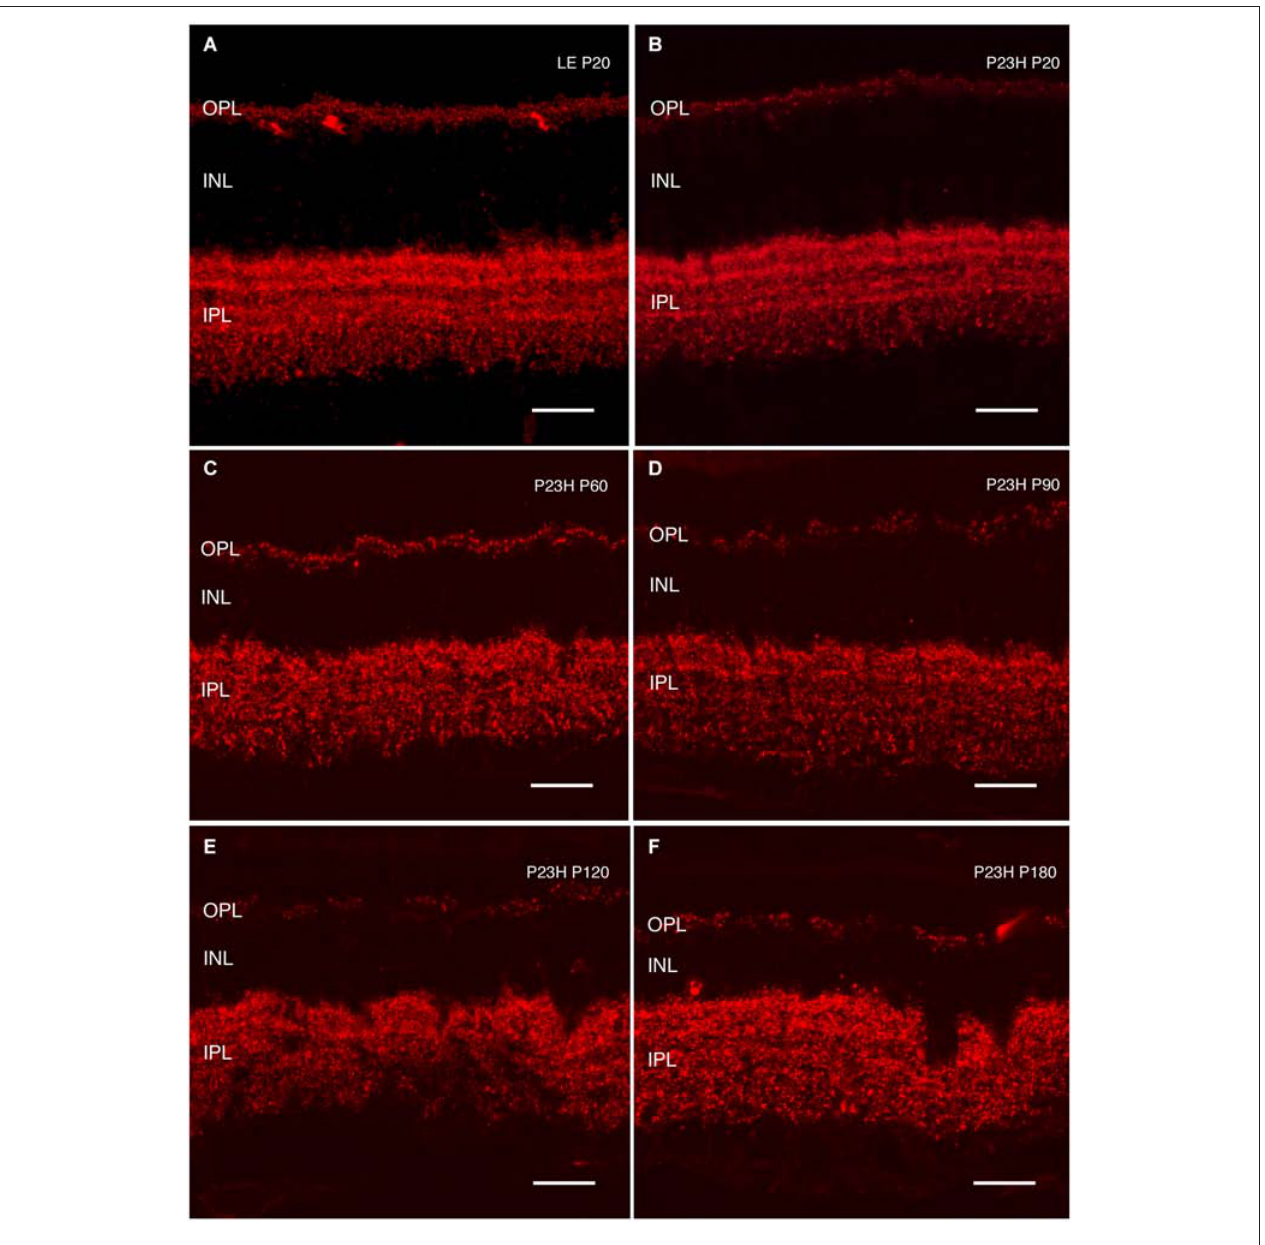
loss of connectivity was seen at the OPL, as well as increased disorganization at the IPL layer. ONL: outer nuclear layer; OPL: outer plexiform layer; INL: inner nuclear layer; IPL: inner plexiform layer. Scale bar: 20 µ